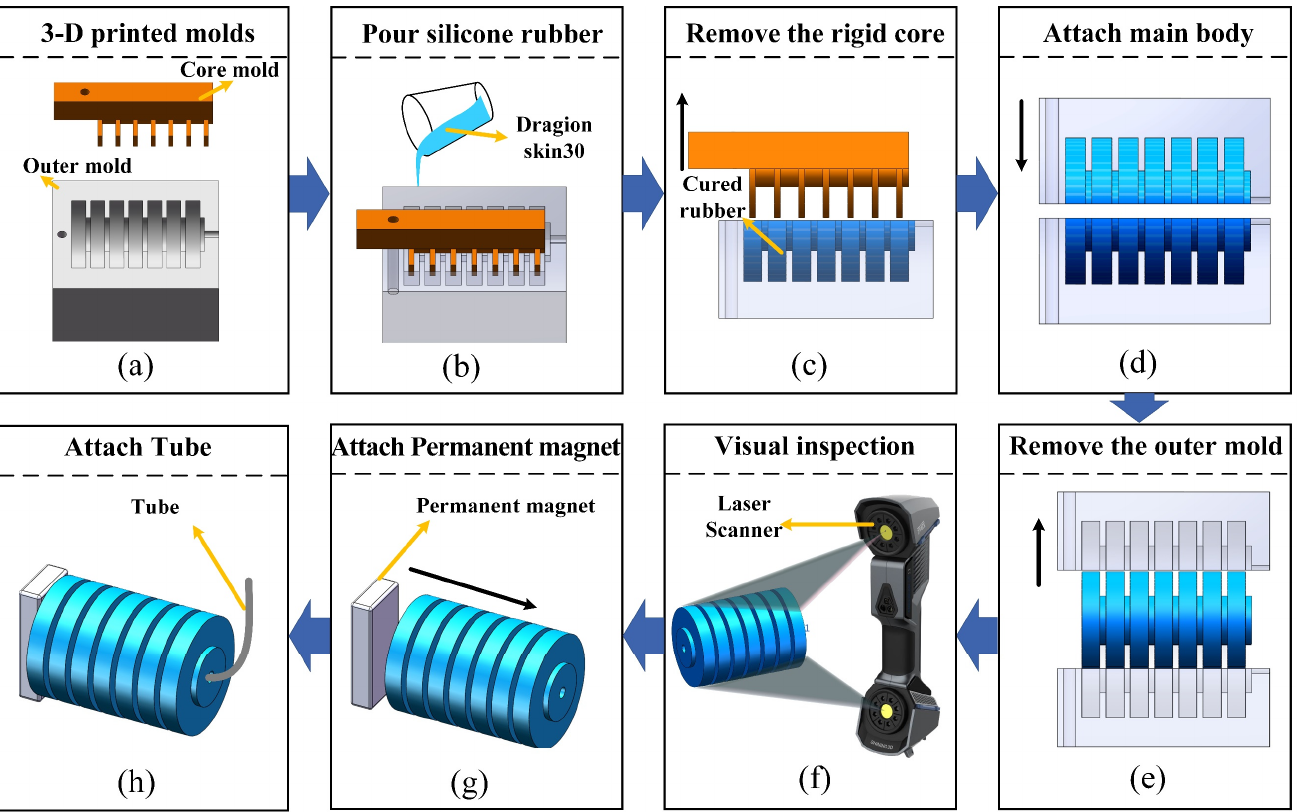
Figure 4. The manufacturing process of the robot ( a ) Prepare molds with 3-D printing; ( b ) Pour silicone rubber pre-elastomer (Dragon-skin30 from Smooth-On, Inc, Macungie, PA, USA); ( c ) Remove the rigid core; ( d ) Gluing the two parts; ( e ) Detach the outer molds; ( f ) Detect the soft body by laser scanner; ( g ) Assemble the soft body and a permanent magnet; ( h ) Insert rubber tube and sealing.